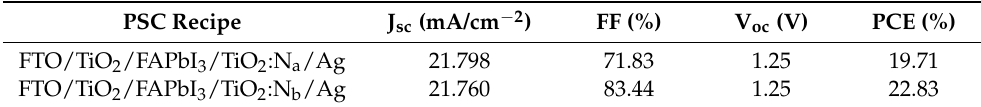
Table 4. Summarised photovoltaic parameters of the two recipes from SCAPS